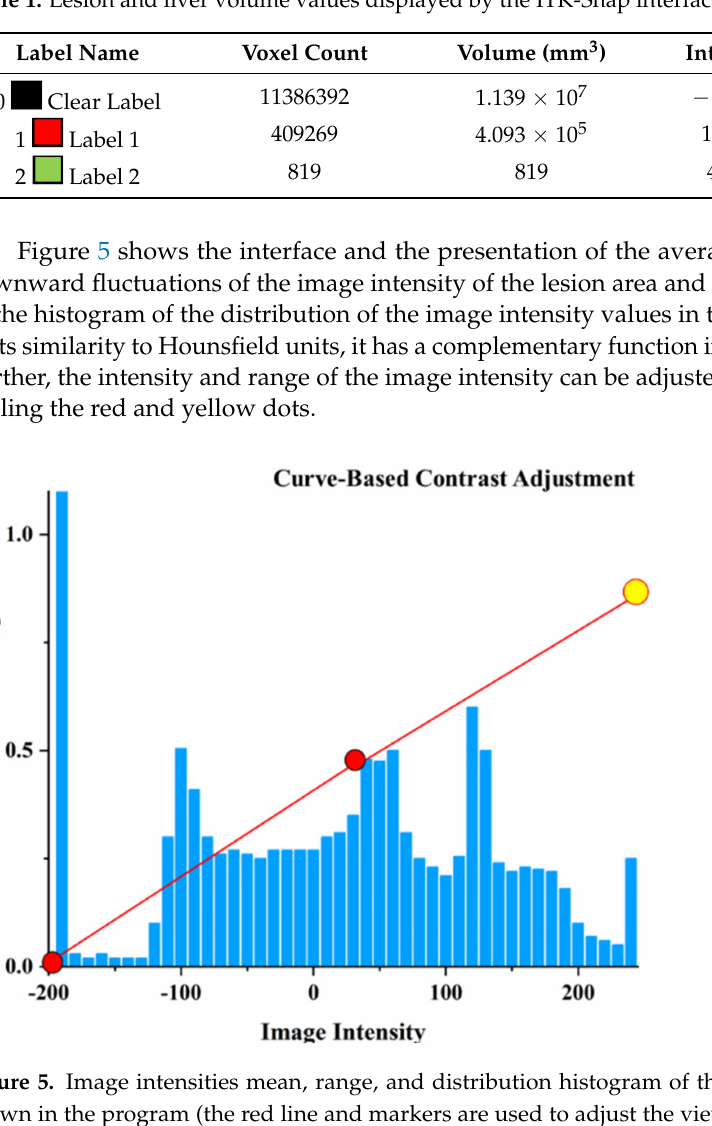
Table 1. Lesion and liver volume values displayed by the ITK-Snap interface.